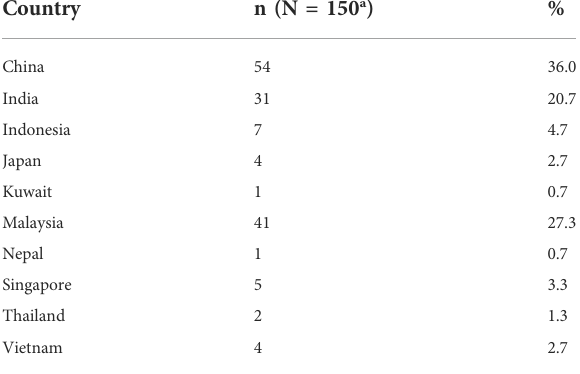
TABLE 1 Number of respondents by country.